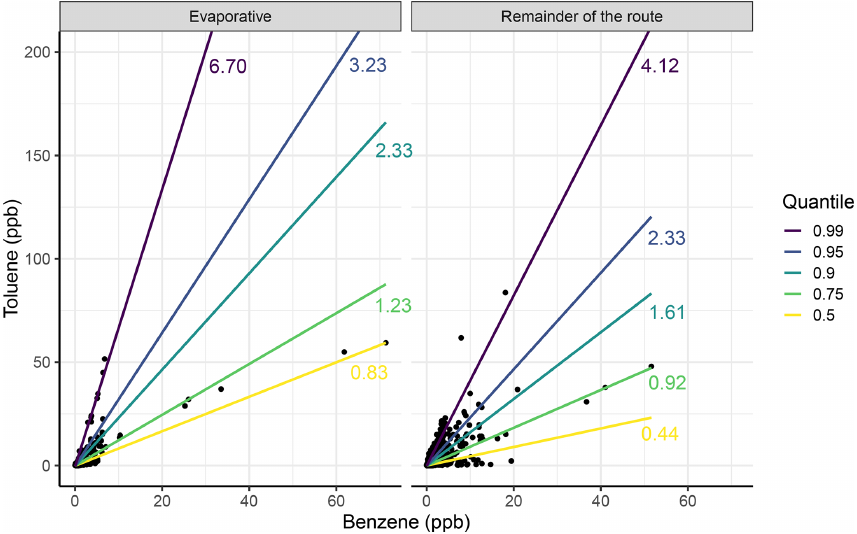
Figure 11. The toluene-to-benzene (T / B) ratio for the evaporative areas (Hull Road and James Street) and for the remainder of the route at quantiles of 0.99 (purple), 0.95 (dark blue), 0.9 (turquoise), 0.75 (green) and 0.5 (yellow), with the corresponding slope values also displayed. The toluene and benzene values for each of the comparative figures were produced using data collected from all 30 repeat measurement